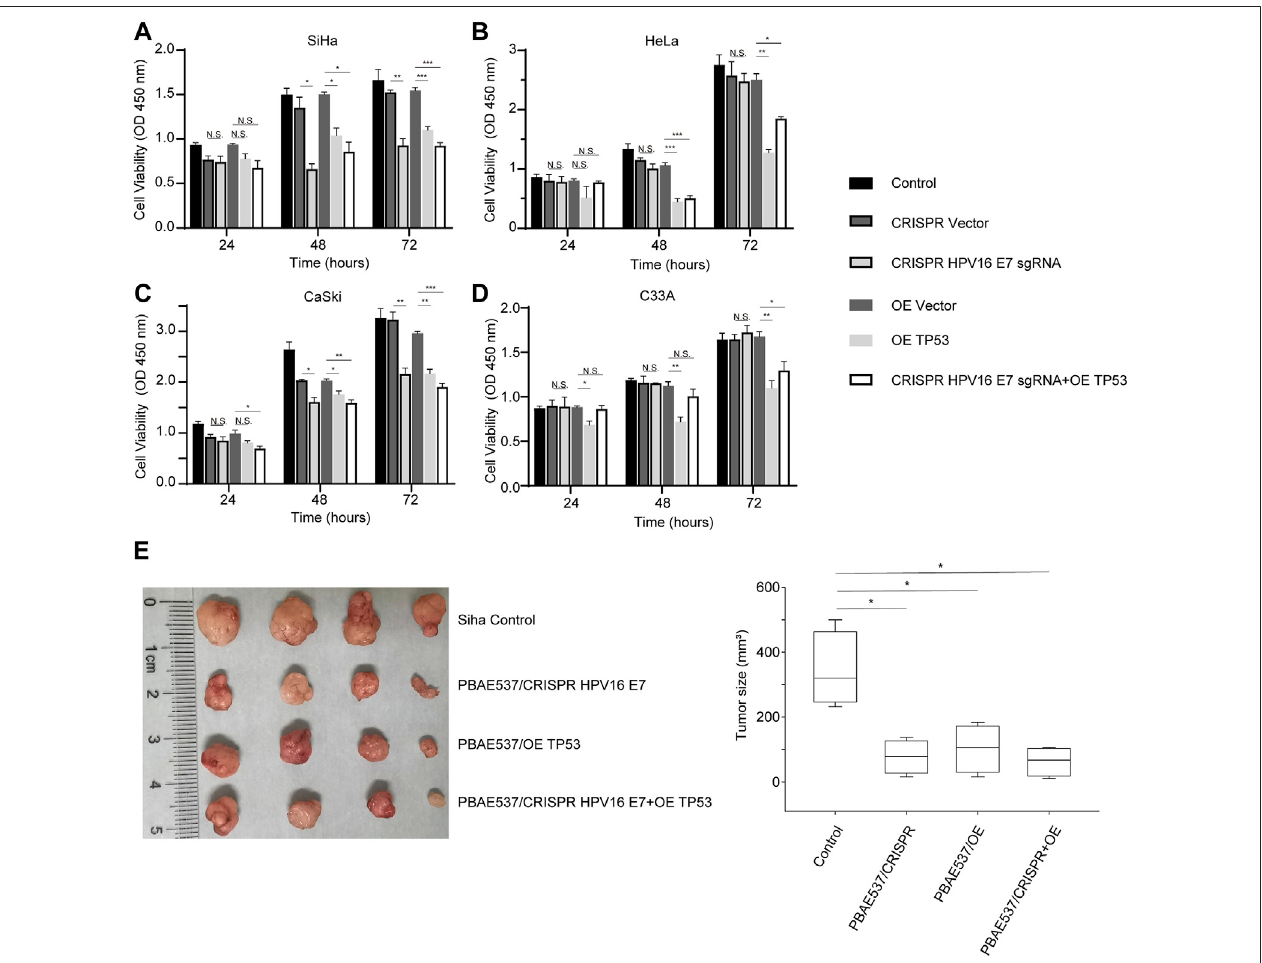
FIGURE 5 | Growth inhibition of cervical cancer cells by PBAE537 – therapeutic plasmid polyplex NPs in vitro and in vivo . (A – C) The CCK-8 method was used to detect the cell viability of (A) SiHa, (B) HeLa, (C) S12, and (D) CaSki cells at 24, 48, and 72 h after treatment with nanoparticles (PBAE537/plasmid 60:1) composed of PBAE537 and three targeted plasmids (HPV16 E7 inactivation group, p53 overexpression group, and 1:1 mixture of the two plasmids group). (E, F) SiHa cells were injectedsubcutaneouslyintotherighthindlimbofBALB/c-numice.Whenthetransplantedtumorgrewtoapproximately35 mm 3 ,NPsconsistingofPBAE537and the CRISPR/Cas9 plasmid targeting HPV16 E7 and p53 were injected intratumorally (60:1). NPs were injected as a volume of 100 µL containing 60 μ g of plasmid once every 4 days. (E) The subcutaneously formed tumors were photographed, and (F) the estimated sizes were measured after treatment with NPs. One-way ANOVA was used for statistical analysis, *: p < 0.05, **: p < 0.01, ***: p < 0.001, N.S.: no signi fi cant